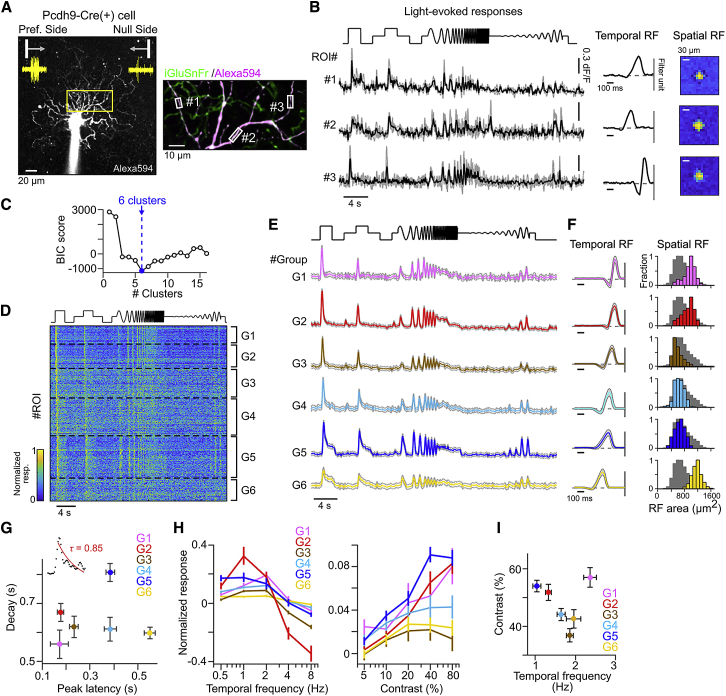
Functional Characterization of Glutamatergic Inputs to ON DS Cells(A) Left: labeled ON DS cell with its firing responses to motion stimulus (yellow). Scale bar, 20 μm. Right: field of view (FOV rectangle in left). Rectangles, regions of interest (ROIs). Scale bar, 10 μm.(B) Light-evoked glutamate signals (gray, each trial; black, averaged signal), temporal RF (gray line, event timing), and spatial RF (yellow) in example three ROIs shown in (A).(C) Relationship between Bayesian information criterion score (see STAR Methods) and number of clusters in the Gaussian mixture model. Blue, estimated optimal number of clusters.(D) A heatmap showing glutamate signals for the detected six clusters (G1–G6). Black dotted lines, borders of each cluster. 1,175 ROIs and 6 ON DS cells.(E) Averaged light-evoked glutamate signals for the six clusters. Gray shade, SD.(F) Temporal RF (left; gray shade, SD) and histograms of spatial RF area (right; gray shade, all ROIs).(G) Decay and peak latency in responses to static flashing spot (diameter, 500 μm; 100% contrast). (Inset) Measured glutamate signal (black dots) and fitted exponential curve (red line) to calculate decay constant τ.(H) Mean tunings to temporal frequency (left) and contrast (right) in the six clusters.(I) Preferred contrast and frequency calculated by the tunings in individual ROIs.Averages in (G)–(I) are mean ± SE.See also Figure S3.